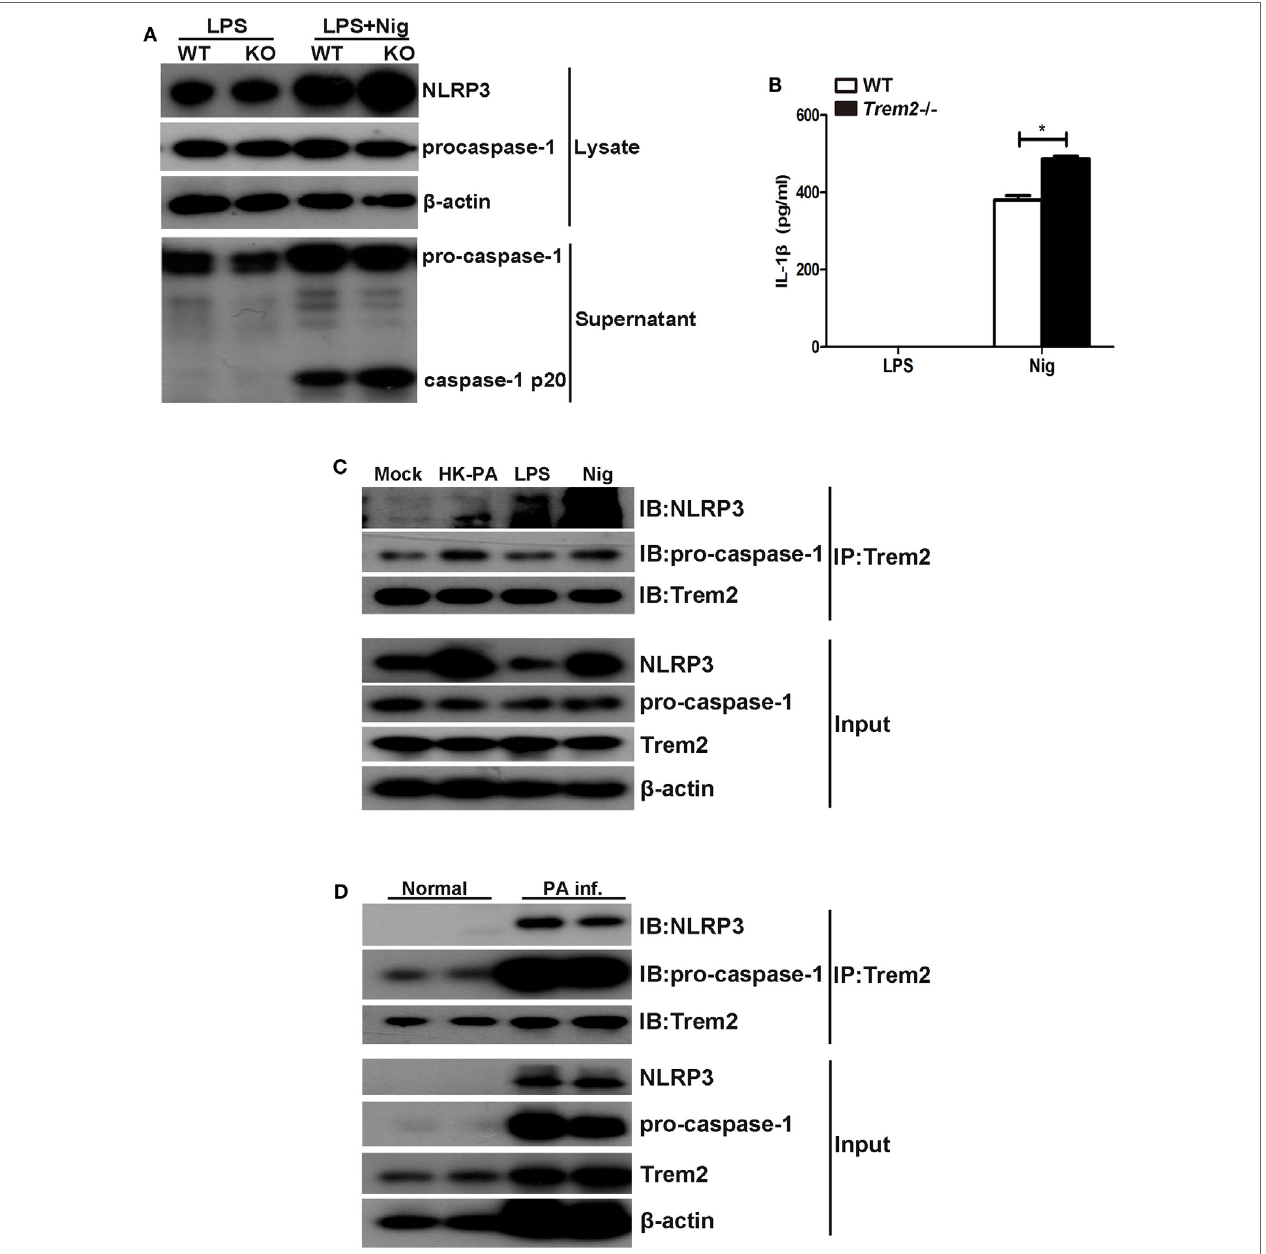
FigUre 8 | Triggering receptors expressed on myeloid cells 2 (TREM-2) inhibited caspase-1-dependent pyroptosis by mediating the NLRP3 inflammasome. (a) Immunoblot analysis of cleaved caspase-1 (p20) in culture supernatants of LPS-primed wild type (WT) and Trem2 − / − bone marrow-derived macrophages (BMDMs) stimulated with nigericin, immunoblot analysis of the precursors of caspase-1, and NLRP3 in lysates of those cells (Input). (B) IL-1 β in supernatants from LPS-primed WT and Trem2 − / − BMDMs stimulated with nigericin were tested by enzyme-linked immunosorbent assay. (c) BMDMs from WT C57BL/6 mice were treated with heat-killed P. aeruginosa at MOI of 5 for 6 h or stimulated with nigericin, followed by immunoprecipitation using anti-TREM2 antibody. The immunoprecipitates were further immunoblotted with anti-TREM2, anti-caspase-1, and anti-NLRP3 antibodies. The blot shows the detection of caspase-1 and NLRP3 in the TREM2 immunoprecipitates. (D) Normal and infected corneas from WT C57BL/6 mice were harvested at 5 days after Pseudomonas aeruginosa infection, followed by immunoprecipitation using anti-TREM2 antibody. The immunoprecipitates were further immunoblotted with anti-TREM2, anti-caspase-1, and anti-NLRP3 antibodies. The blot shows the detection of caspase-1 and NLRP3 in the TREM2 immunoprecipitates. Data were the mean ± SEM and represent three individual experiments. * P <